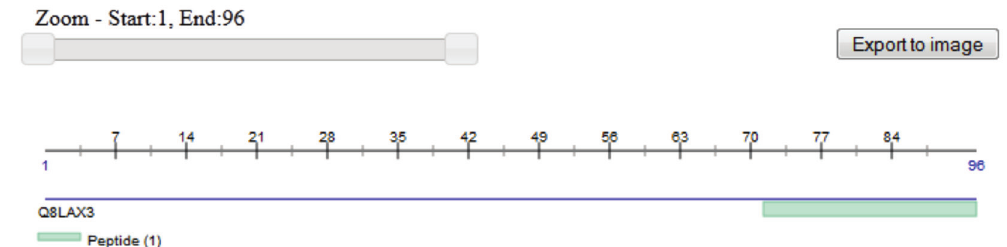
Figure 2. Visualization of a peptide using the FeatureViewer